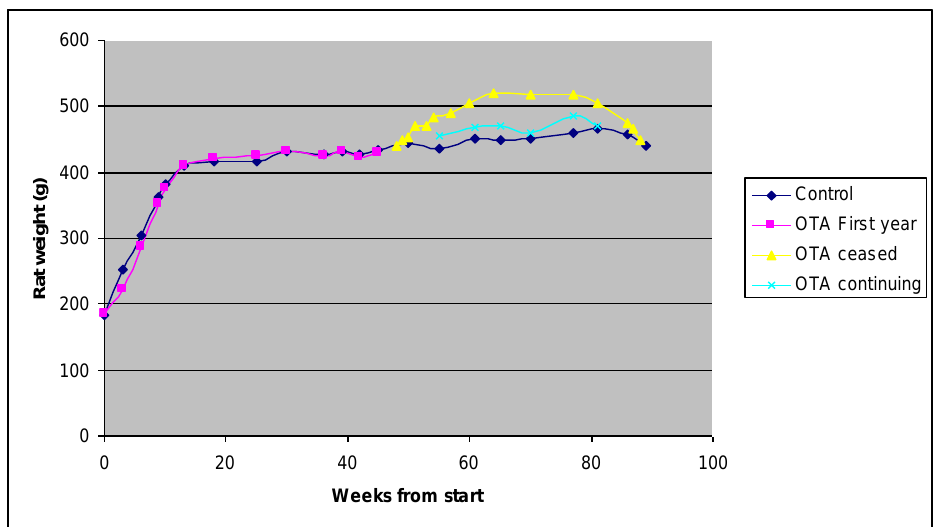
Figure 1. Comparative mean body weight in control and OTA-treated groups from the beginning of dietary OTA exposure (10 weeks old), showing matching of treated rats and controls during the first 10 months and significant increase to a new maximum in the sub-group that ceased OTA at that